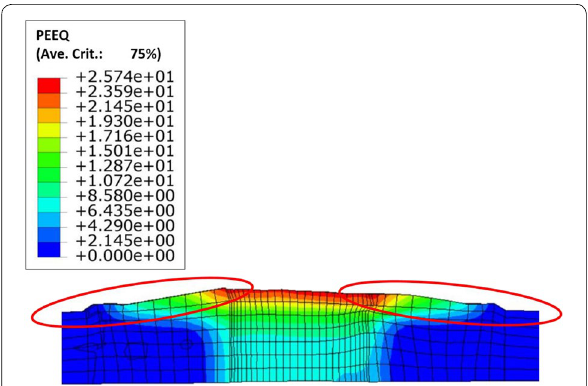
Figure 8 Deformation of the material at the cross-section of the plunging step at the rotational speed of 1400 [112]